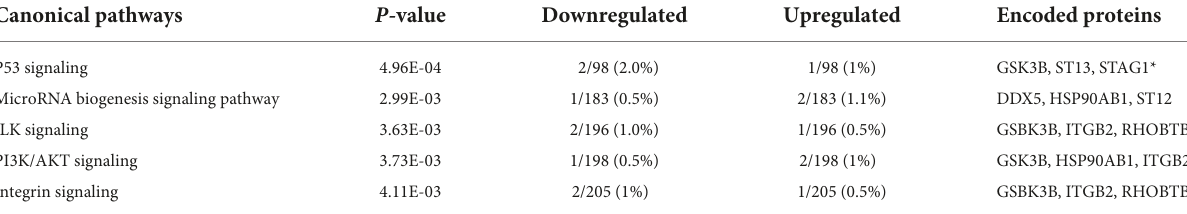
TABLE 4 Top canonical pathways enriched in the 34 ventriculomegaly unique